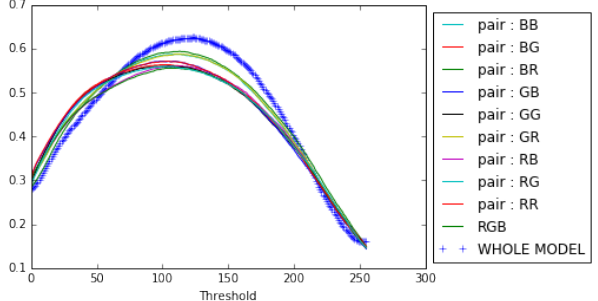
Figure 10. F β measure curves for opposing color pairs, RGB color space and the whole model on the ECSSD